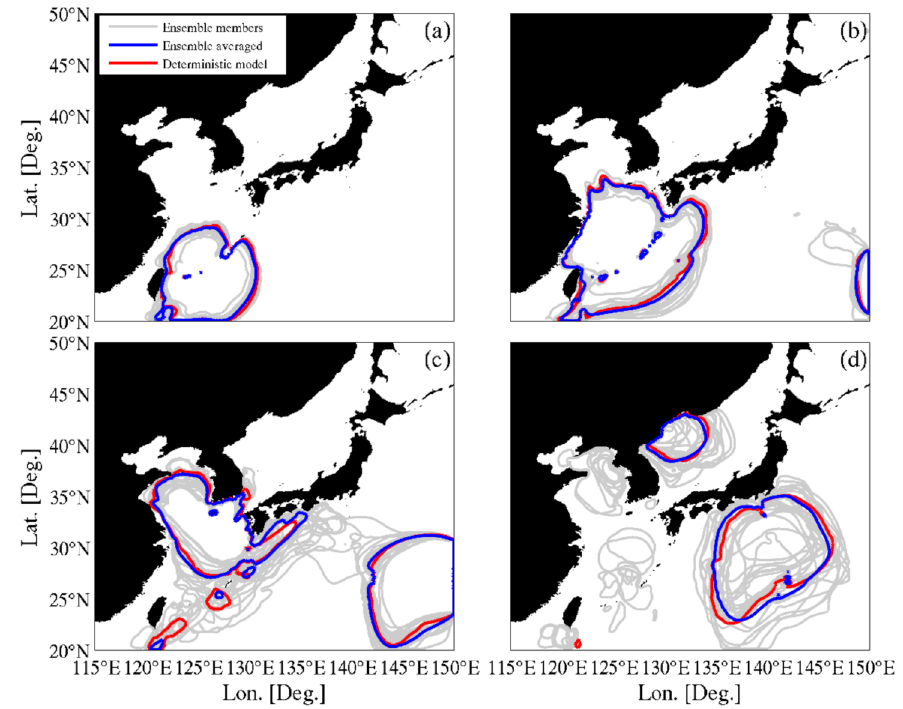
Figure 4. Comparison of the results of each ensemble model member with a significant wave height of 3 m, the result of the ensemble mean, and the result of a deterministic forecast model (forecast lead times of ( a ) +00 h, ( b ) +24 h, ( c ) +48 h, and ( d ) +72